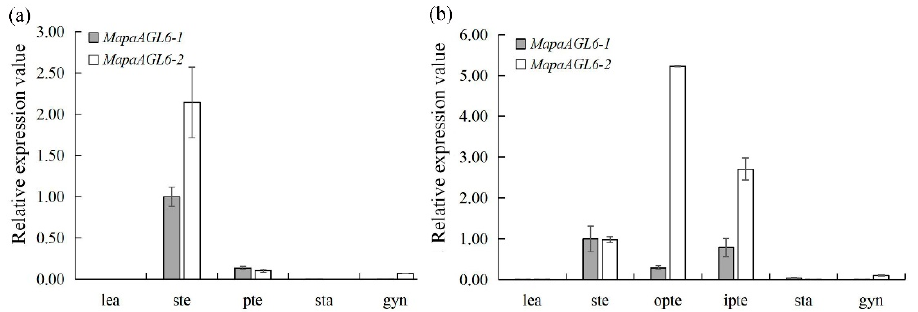
Figure 4. Expression of MapaAGL6-1 and MapaAGL6-2 in the juvenile leaves (lea), sepaloid tepals (ste), petaloid tepals (pte), outer petaloid tepals (opte), inner petaloid tepals (ipte), stamens (sta), and gynoecia (gyn) detected by qPCR with M. patungensis actin as the normalization. ( a ) Expression of MapaAGL6-1 and MapaAGL6-2 in different floral organs of 27 mm long floral buds and juvenile leaves, respectively; ( b ) expression of MapaAGL6-1 and MapaAGL6-2 in different floral organs of 40 mm long floral buds and juvenile leaves, respectively.